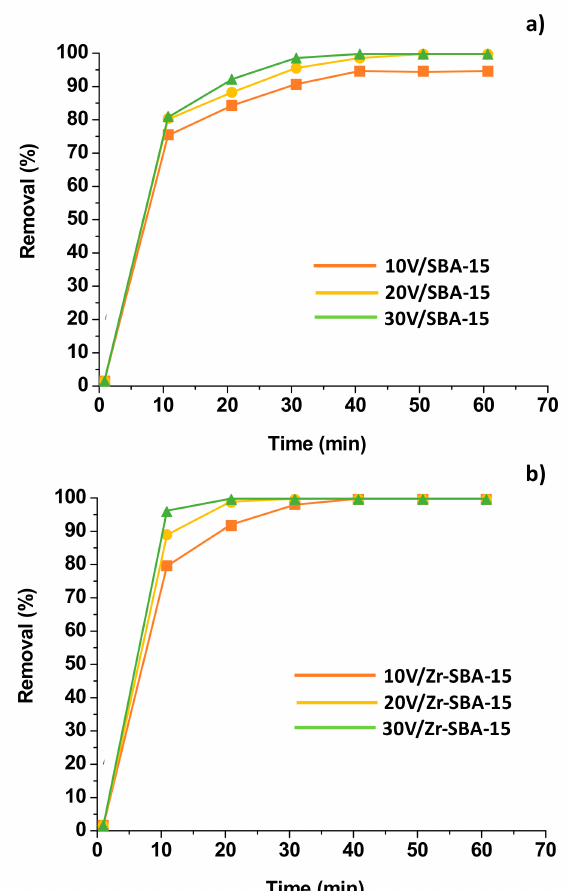
Figure 9. Effect of reaction time and vanadia loading. Reaction conditions: catalyst loading: 1 g/L oil; reaction temperature: 60 ◦ C; H 2 O 2 /DBT molar ratio: 10; reaction time: 60 min; oil/acetonitrile volume ratio: 1:1. ( a ) V 2 O 5 /SBA-15; ( b ) V 2 O 5